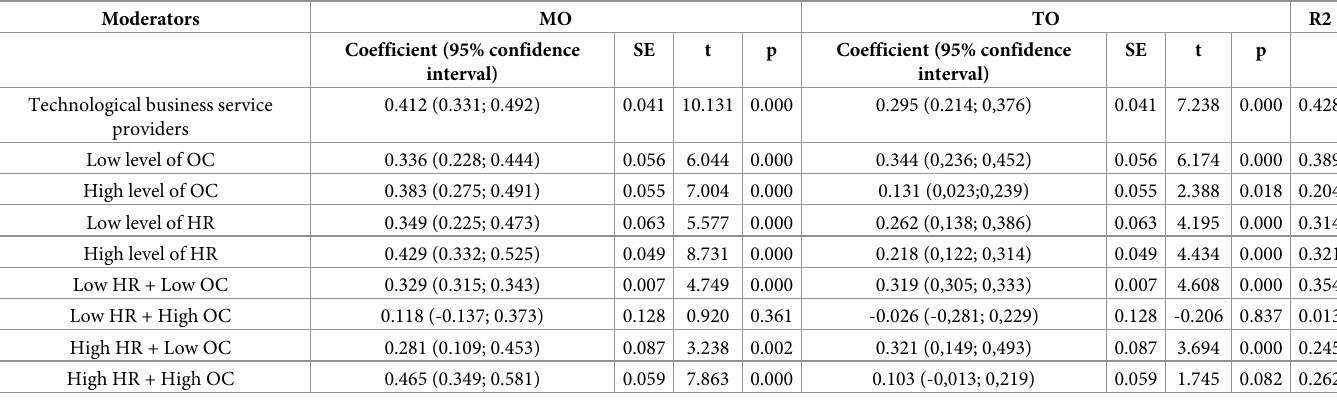
Table 6. Multiple regression